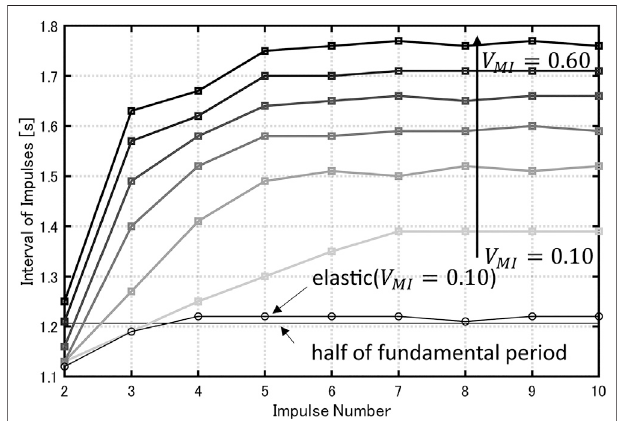
FIGURE 6 | Relation of interval of impulses with impulse